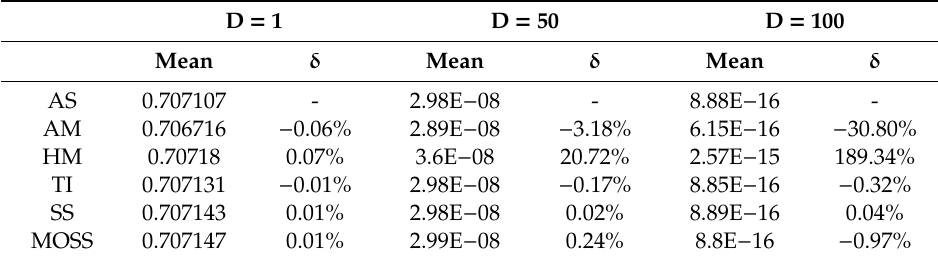
Table 1. True analytical solution (AS) of the BME for the Gaussian model with di ff erent dimensions (D), and the corresponding numerical estimations with K = 50 and α = 0.3 using arithmetic mean (AM), harmonic mean (HM), thermodynamic integration (TI), steppingstone sampling (SS), and multiple one-steppingstone sampling (MOSS). The mean BME and its relative error ( δ ) are based on 10 independent